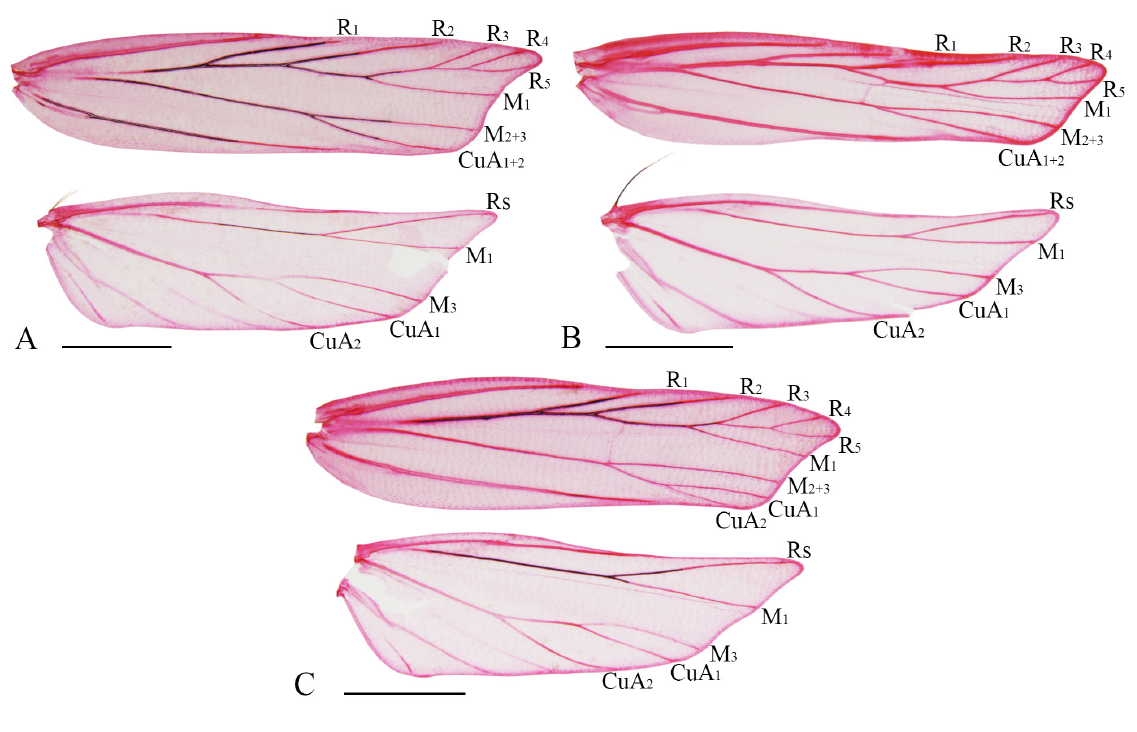
Fig. 2. Wing venations of Antiochtha spp., all paratypes. A . A. erromera sp. nov., slide No. WYS20277. B . A. hainanensis sp. nov., slide No. WYS20058. C . A. miniscula sp. nov., slide No. WYS20261. Scale bars = 1.0